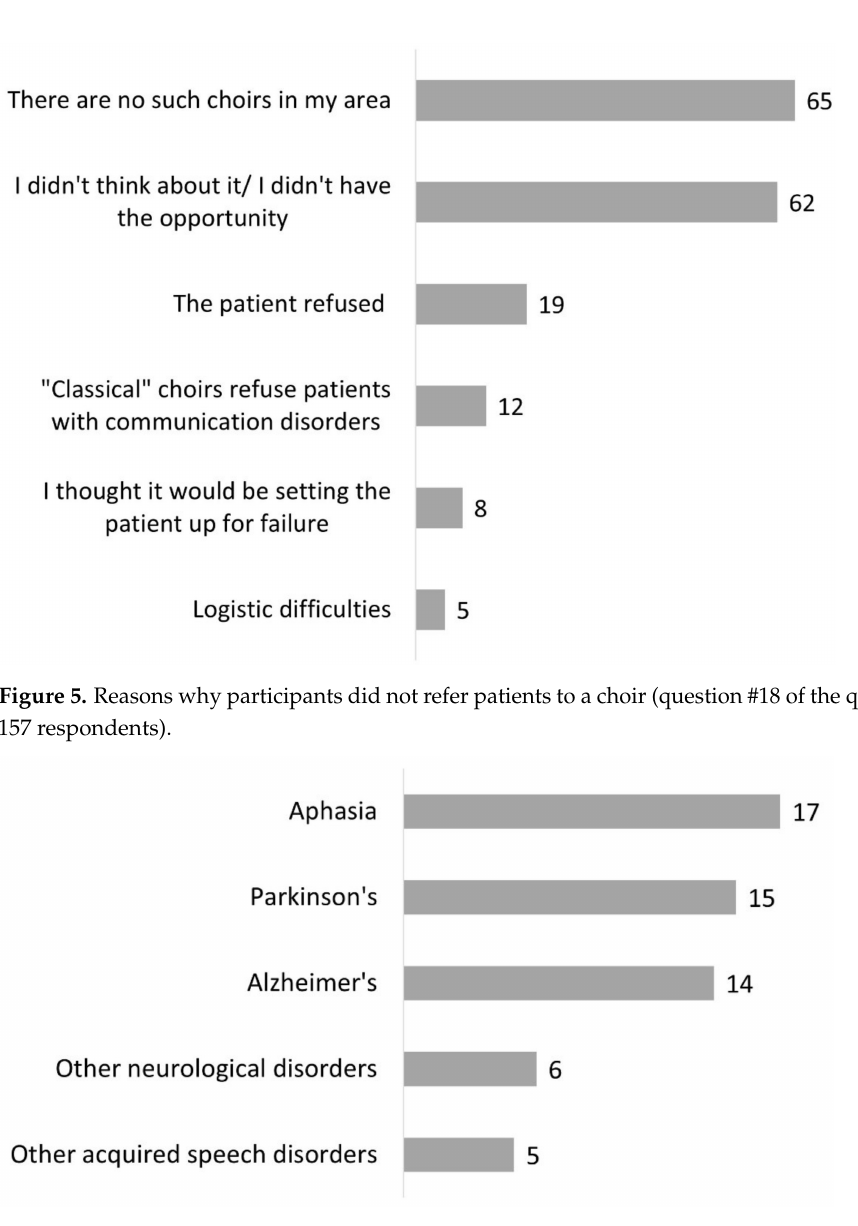
Figure 6. Type of disorders for which participants created a choir (question #16 of the questionnaire, 28 respondents).